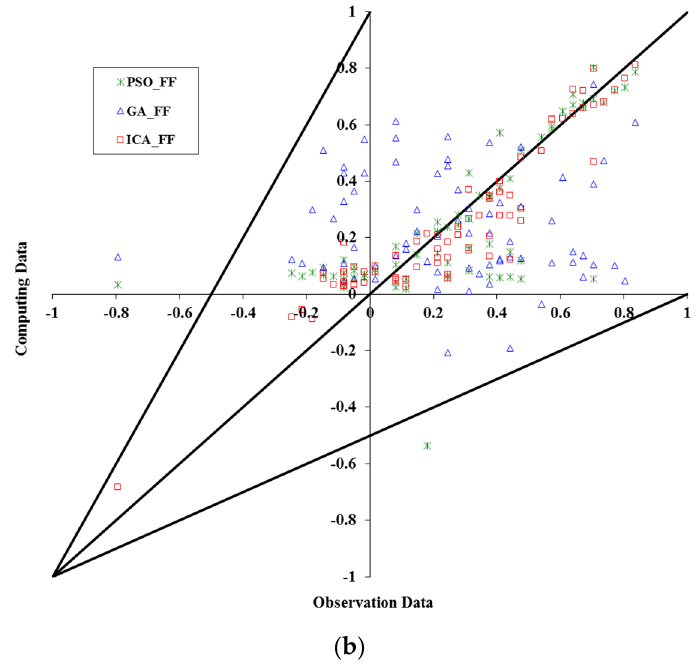
Figure 6. Comparison of the selected ICA-ANN with GA-ANN and PSO-ANN in ( a ) training and ( b ) testing. Table 8. Comparative summary of the values of f b and f c,b , defined using the pull ‐ off method and ICA ‐ ANN, respectively.